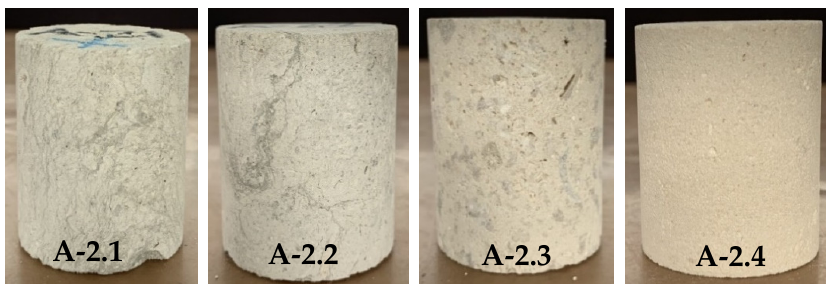
Figure 2. PETRONS-2 core plug samples. Table 1. Core plug samples from PETRONS-1 and PETRONS-2 wells used in the current study.